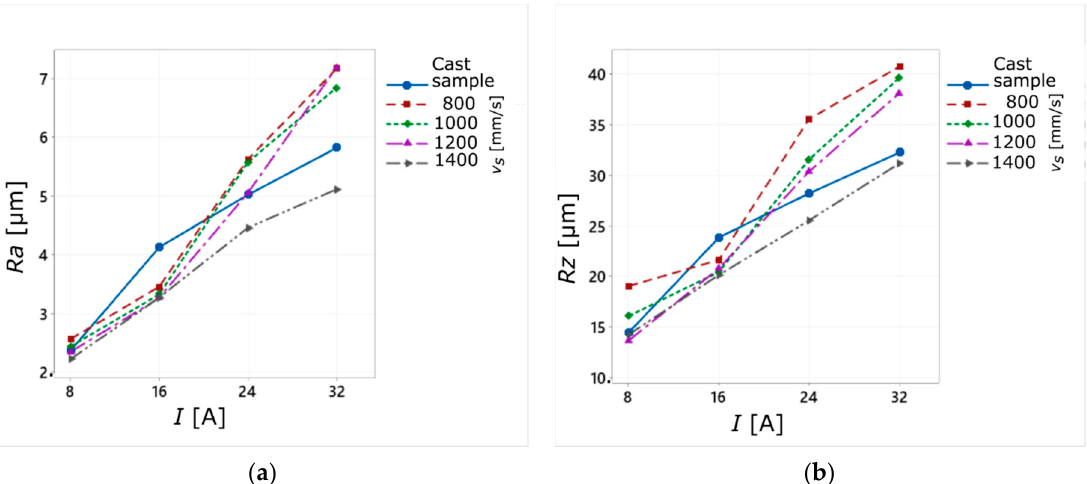
Figure 9. Relationship between the current amplitude ( I ) and the laser scanning speed ( v s ) and the average values of surface roughness parameters for the sintered sample and the cast sample: ( a ) Ra ; ( b ) Rz .